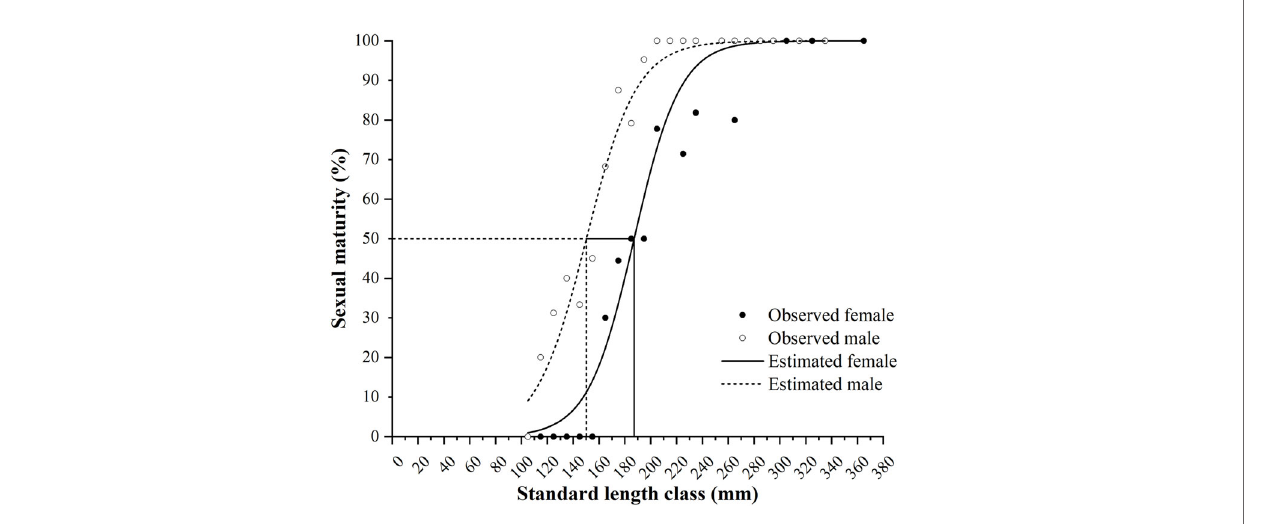
FIGURE 8 | Female and male maturity of Larimichthys crocea in standard length class (mm) and the logistic curves. Vertical solid line and dash line indicate the estimated SL 50 for females and males, respectively.